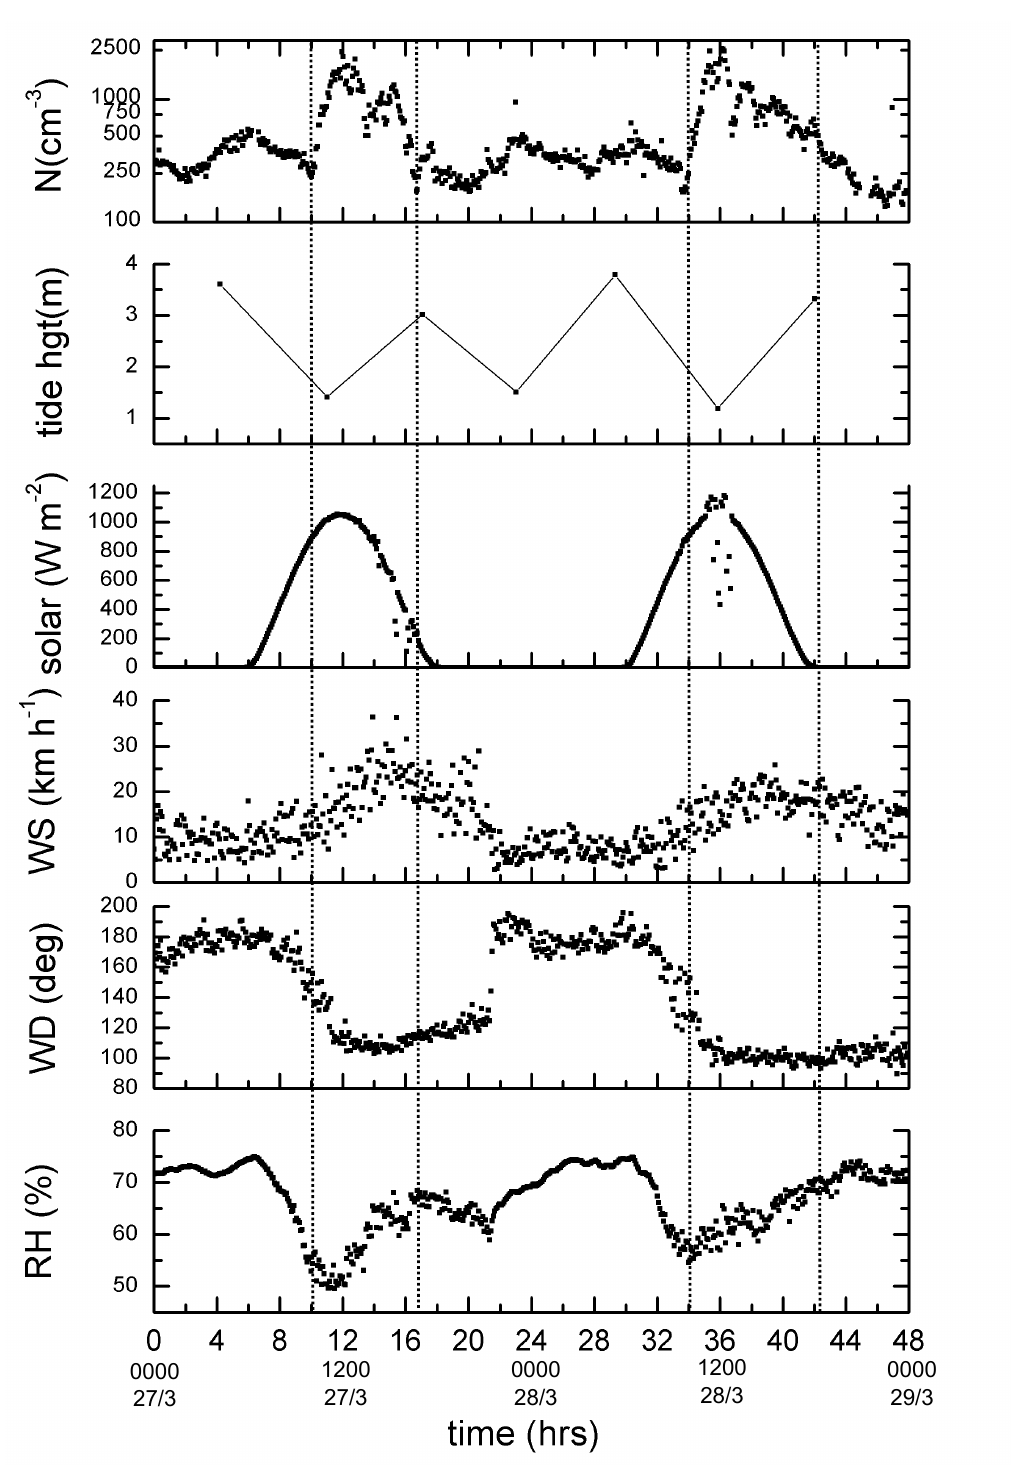
Fig. 6. Time series of particle concentration (4 < d < 165nm), N (cm − 3 ); tide height at Agnes Water, tide hgt (m); solar intensity, solar (Wm − 2 ); wind speed, WS (kmh − 1 ); wind direction from true north, WD (deg); and relative humidity, RH (%) for 27 and 28 March 2007. Dashed lines indicate the occurrence of 2 strong nucleation